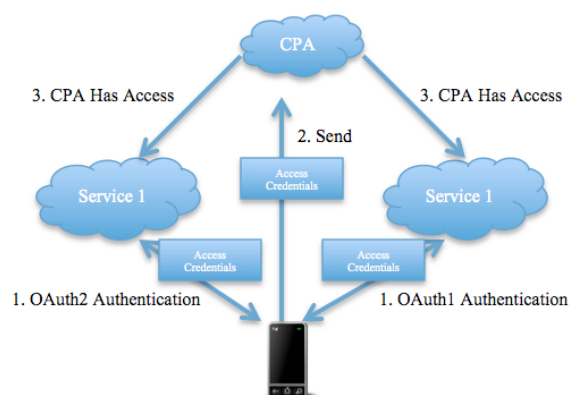
Figure 5. To get the access credentials to where they are needed with the CPA, the user must